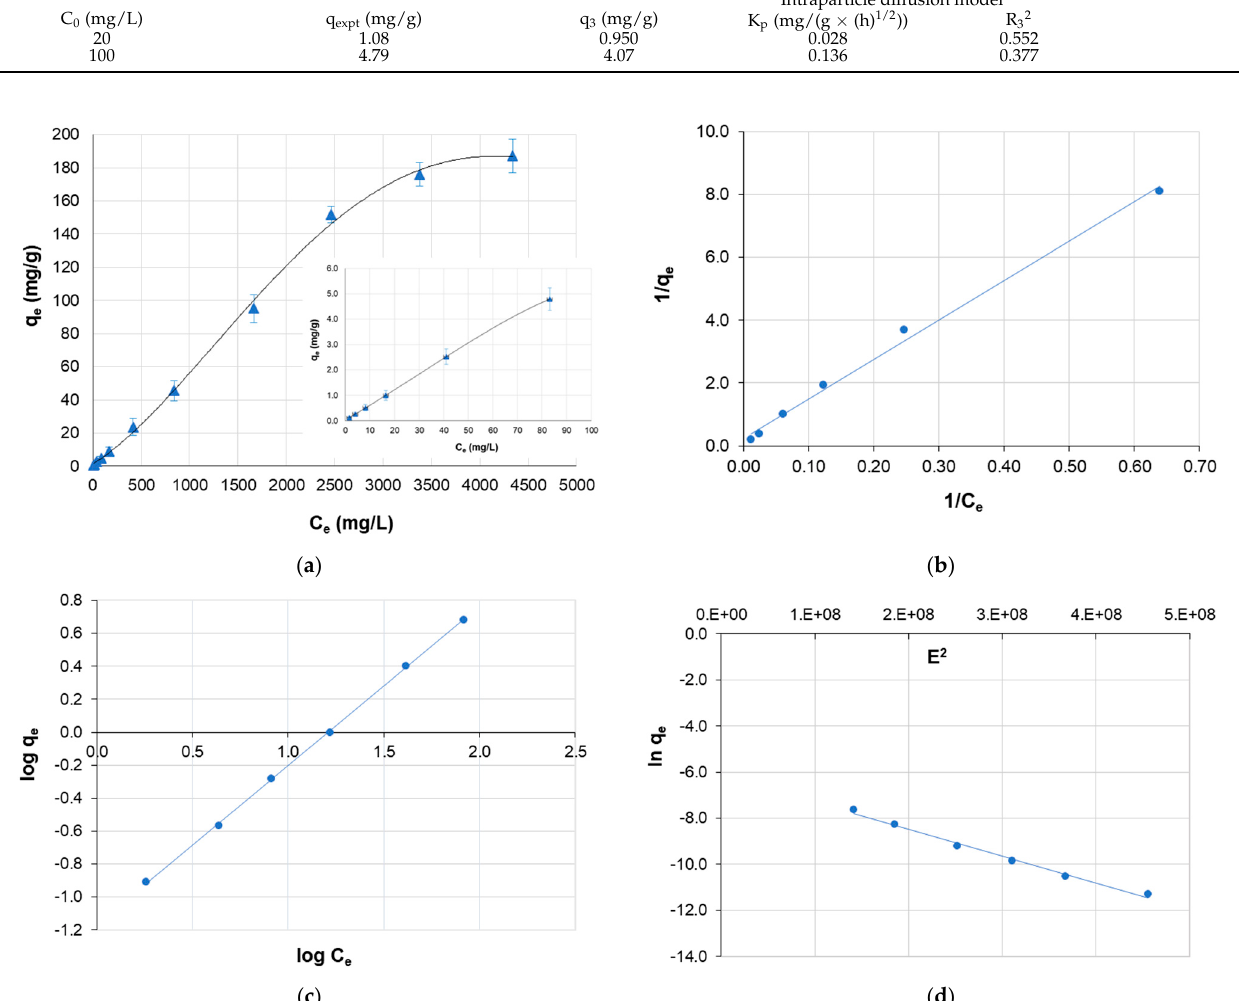
Figure 8. Sorption isotherms of boron on the Mn-biosorbent hydrogel beads at 20 °C: sorption capacity vs. equilibrium boron concentration; initial boron concentration range: 10–5000 mg/L and 2–100 mg/L (the inserted figure) ( a ); boron sorption data fitted with Langmuir model ( b ); boron sorption data fitted with Freundlich model ( c ); boron sorption data fitted with Dubinin–Radushkevich model ( d ); pH: 7.0; hydrogel dose: 1 g/20 mL.